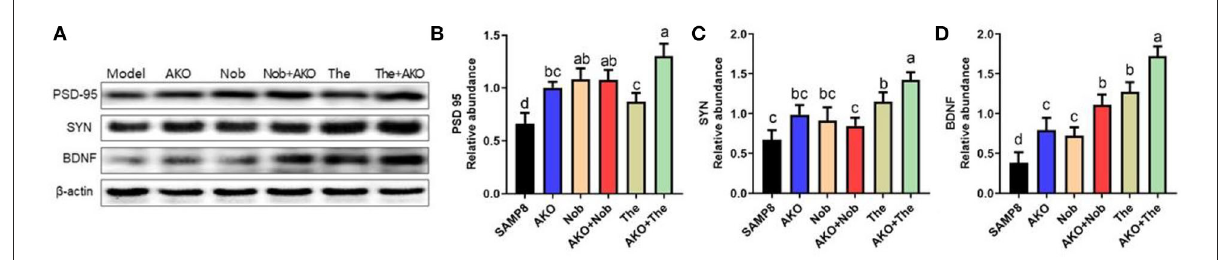
FIGURE5 Effects of synaptic plasticity on the brain. (A) The representative bands were determined by western blotting. (B–D) The relative expressions of postsynaptic density protein-95 (PSD-95) (B) , synaptophysin (SYN) (C) , and brain-derived neurotrophic factor (BDNF) (D) . All data were presented as mean ± SEM. Different letters indicate a significant difference at p < 0.05 by ANOVA.